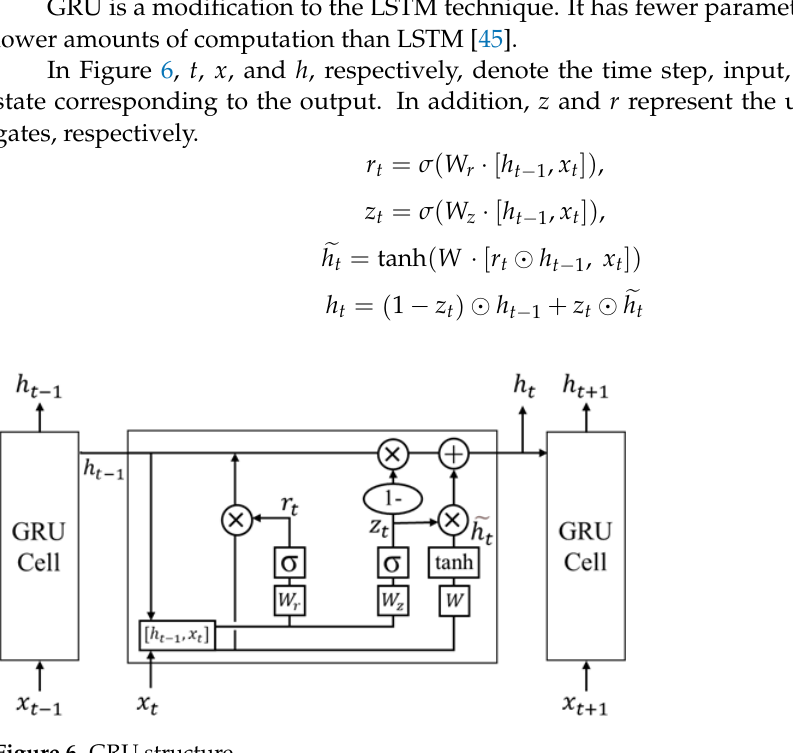
Figure 6. GRU structure.